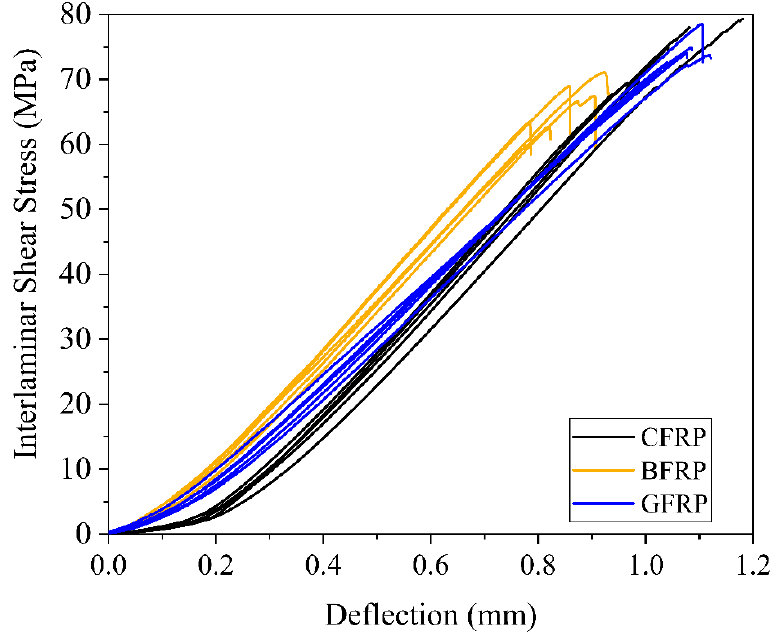
Figure 3. Interlaminar shear stress—deflection curves of apparent interlaminar shear strength testing.